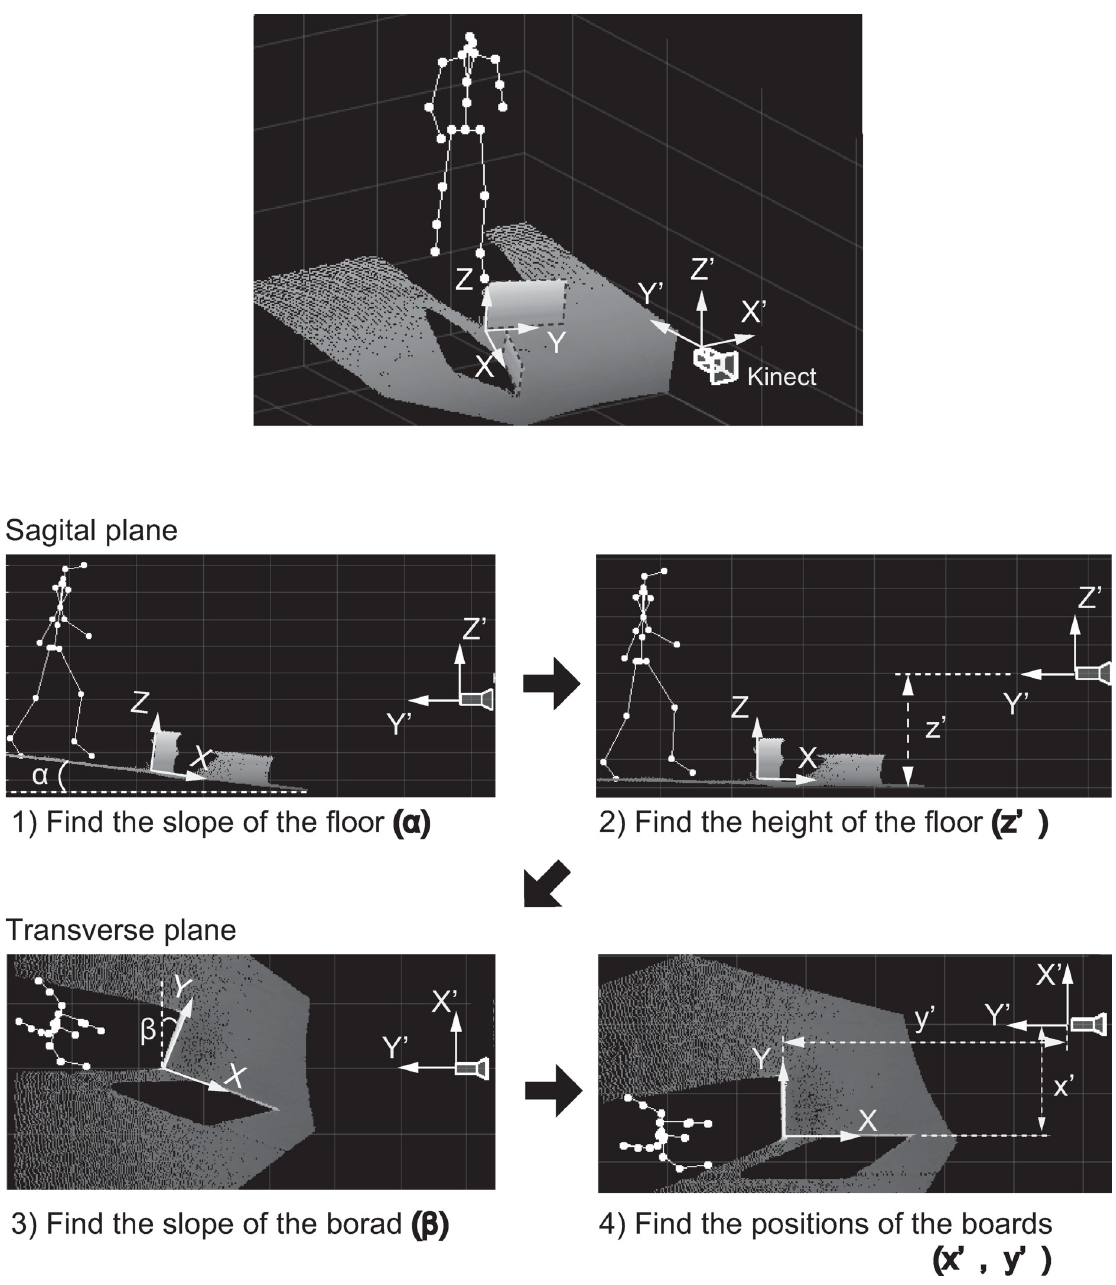
Fig 3. Transformation from the Kinect’s skeleton coordinates (X 0 , Y 0 , Z 0 ) to laboratory coordinates (X, Y, Z). Point cloud (resolution: 640 × 576) data were used for the